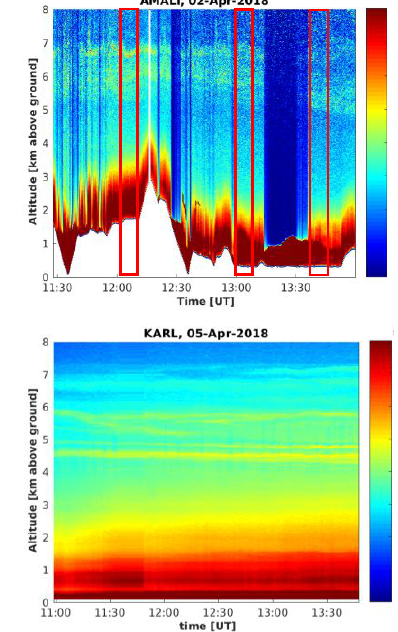
Figure 1: Lidar range-corrected signal (arbitrary units) at 532 nm over Fram Strait (top) and Ny- Ålesund (bottom). Rectangulars indicate temporal windows, for which optical properties were